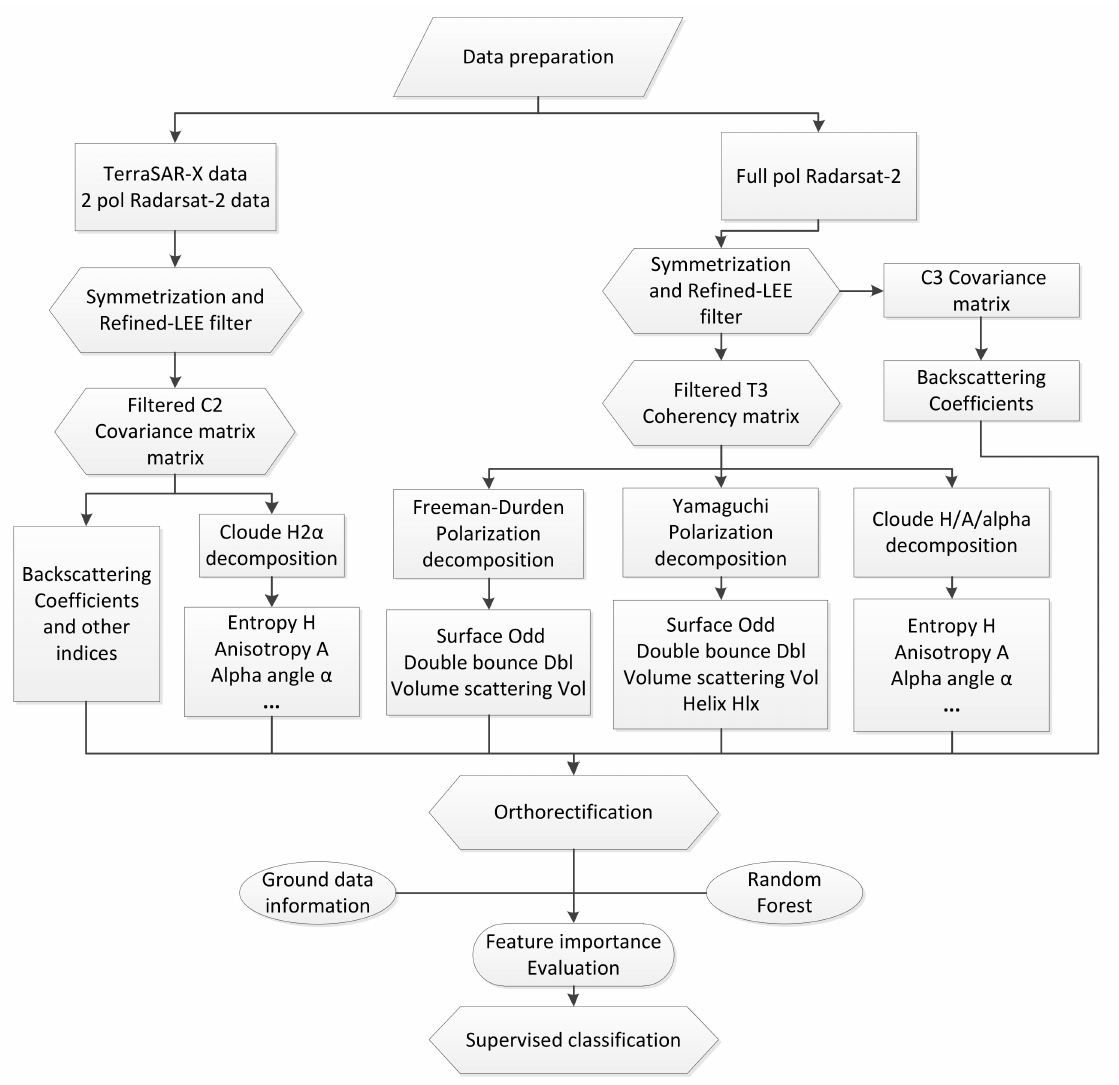
Figure 2. Flowchart for polarimetric SAR data